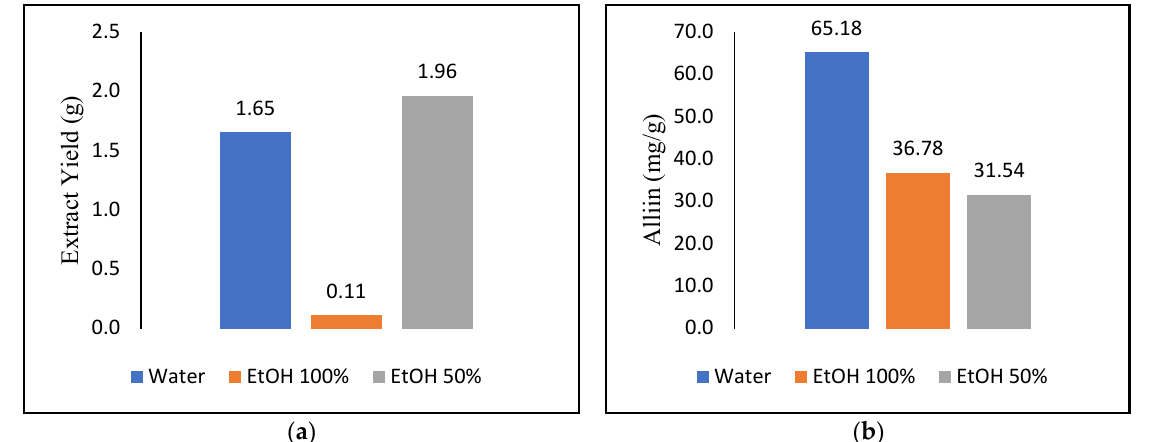
Figure 3. The results of garlic extraction by Soxhlet: ( a ) yield and ( b ) alliin recovery using distilled water, ethanol–water (1:1), and 100% ethanol.